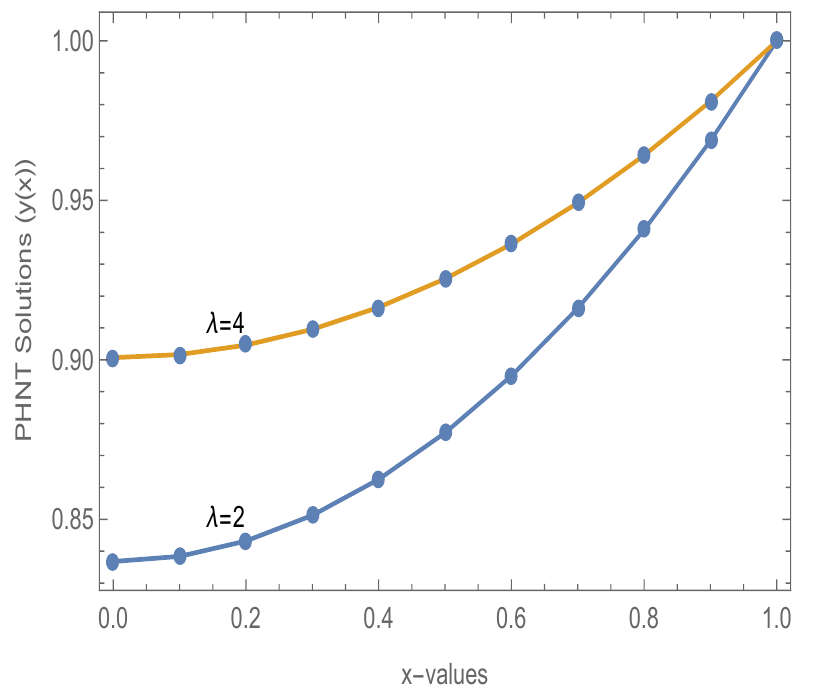
Figure 4. Approximate solutions of PHNT for h = 1 problem